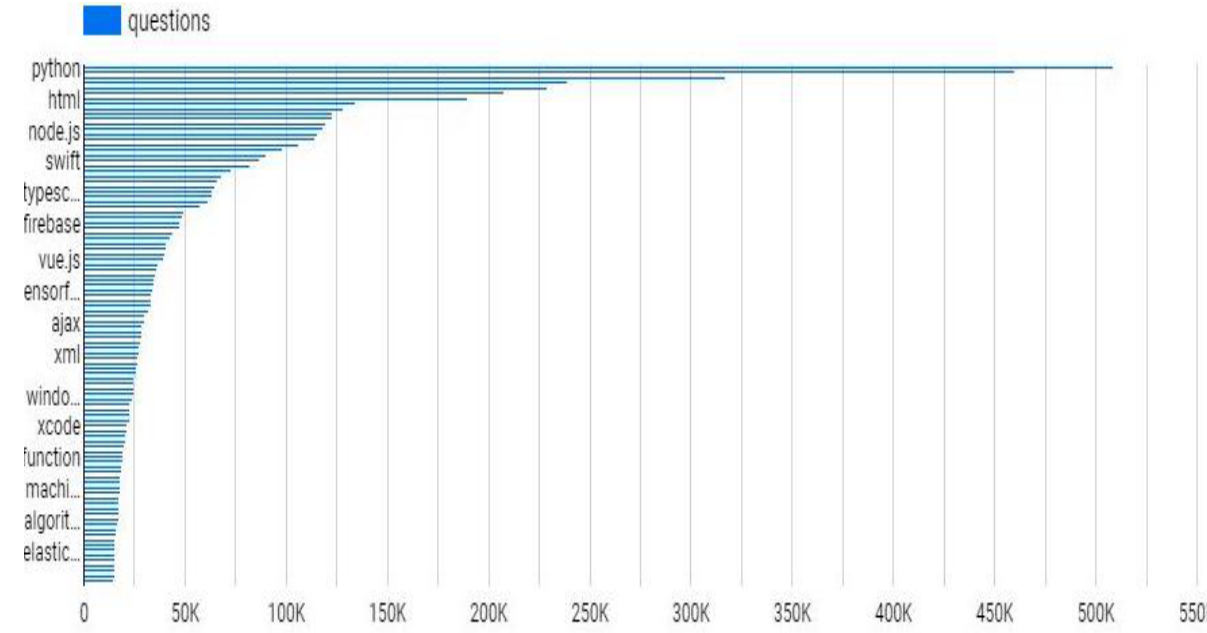
Figure 3. Bar chart for Tags and frequencies between (2018-2019)